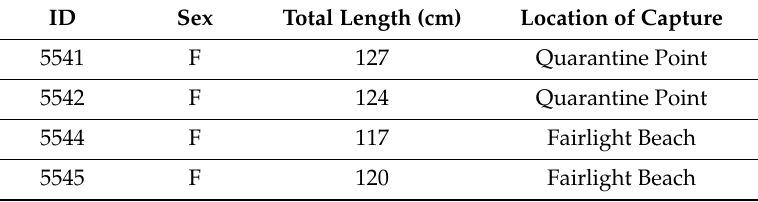
Table 1. Individual and experiment details for four sharks within the